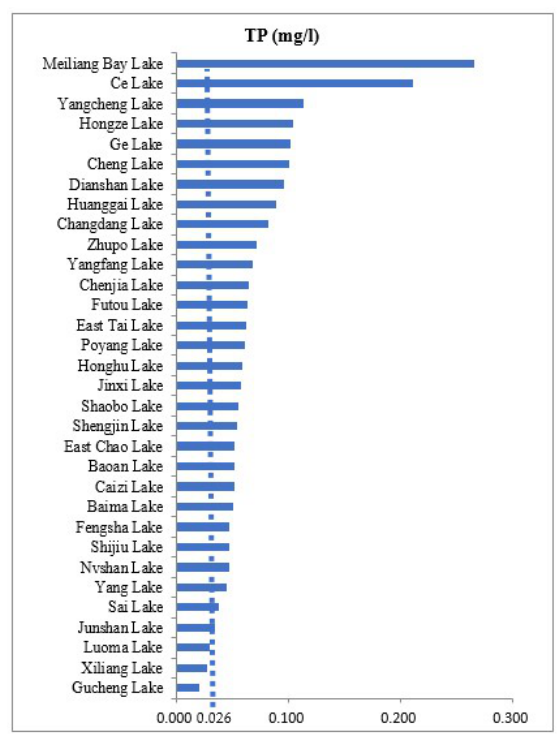
Figure 4. Gradient of water quality with TP pollution in 32 study sites. Total phosphorous concentration > 0.026 µ g/L is shown by the vertical line, i.e., eutrophic and hypertrophic lakes. Lakes are presented on the basis of the smallest to the largest measurements of